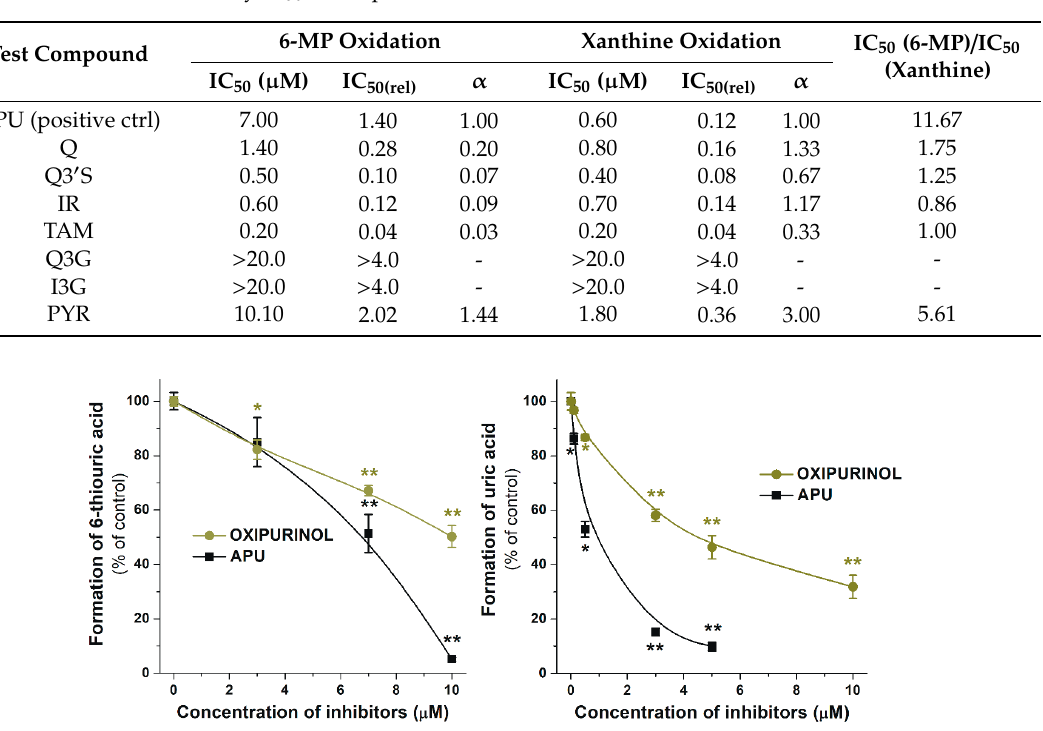
Figure 3. Inhibitory effects of Q and its conjugated metabolites on XO-catalyzed oxidation of 6-MP (5 μ M) after 40 min incubation, in the presence of increasing concentrations of allopurinol (APU), quercetin (Q), isorhamnetin (IR), tamarixetin (TAM), quercetin-3 ′ -sulfate (Q3 ′ S), quercetin-3-glucuronide (Q3G), and isorhamnetin-3-glucuronide (I3G). The 50% inhibition of 6-thiouric acid formation (IC 50 ) is marked with dashed line (* p < 0.05; ** p < 0.01). Table 1. Inhibition of XO-catalyzed 6-TU formation and uric acid formation by APU, Q, Q3 (cid:48) S, IR, TAM, Q3G, I3G, and PYR. IC 50 : concentration of the compound which induces 50% inhibition of metabolite formation, IC 50(rel) = IC 50 of the inhibitor divided by the substrate concentration (5 µ M 6-MP), α = IC 50 of the inhibitor divided by IC 50 of the positive control.